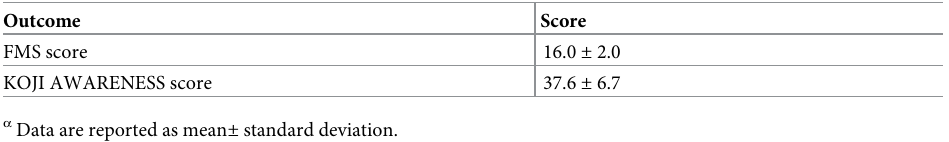
Table 2. Outcome scores in each test (N = 57) α